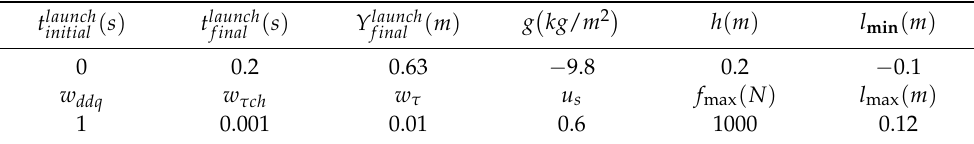
Table 2. The scalar parameters in trajectory planning.